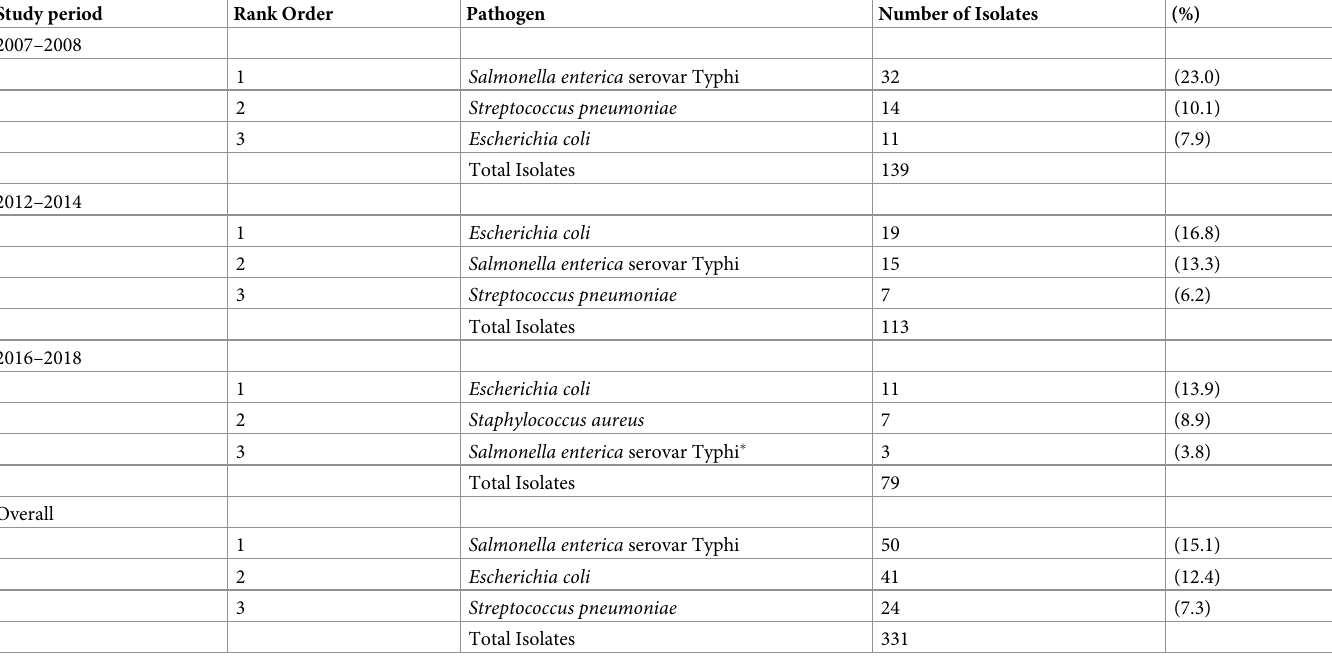
Table 1. Causes of bloodstream infection by rank order, Kilimanjaro Region, Tanzania 2007–2018. Study